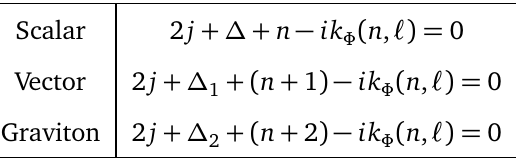
Table 3: The condition ω ∗ = ω for ingoing modes for scalar, vector and graviton n fields with angular momentum quantum number (cid:96)